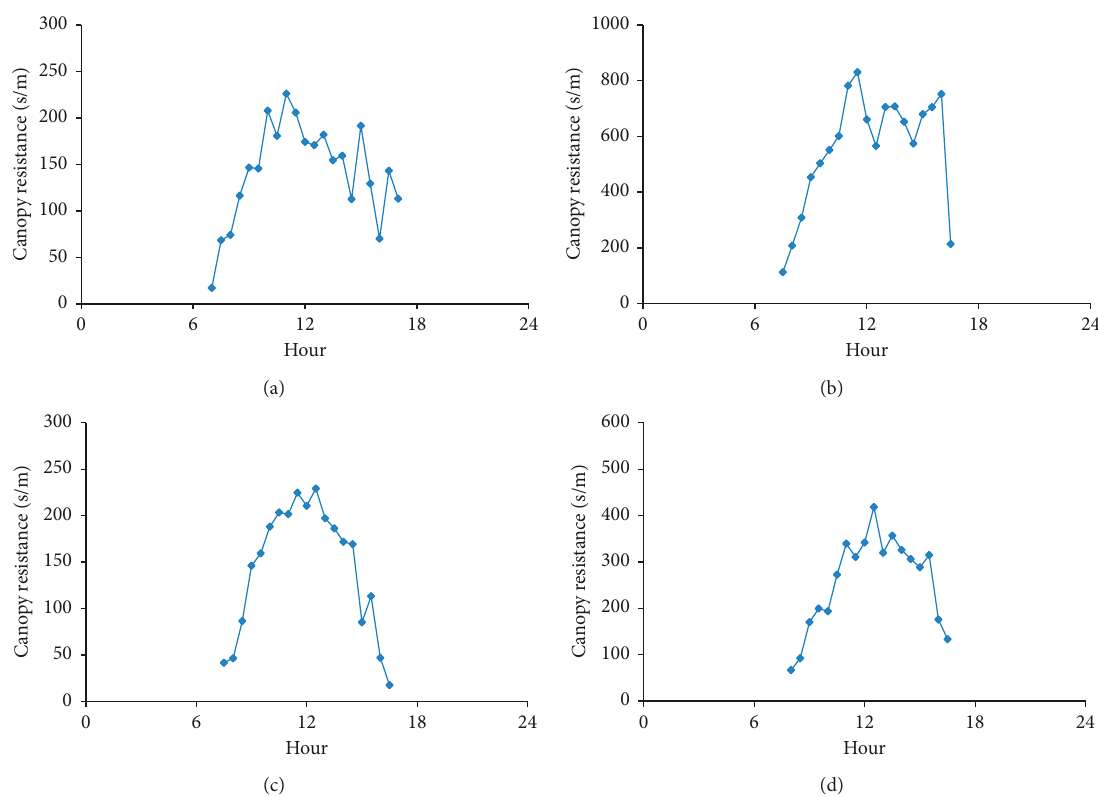
Figure 5: Diurnal variations of canopy resistance (s/m) for the season of (a) warm 2005, (b) cool 2005, (c) warm 2006, and (d) cool